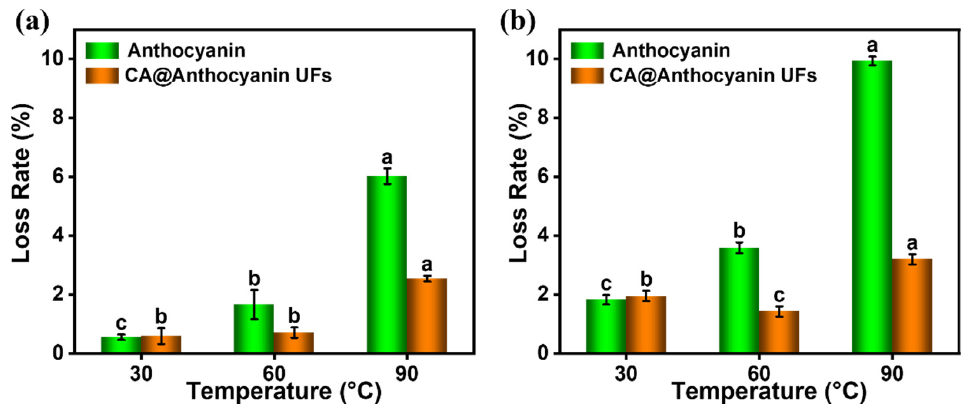
Figure 5. Loss rate of the anthocyanin and CA@Anthocyanin UFs under various water bath temperatures: ( a ) water bath time—2 h; ( b ) water bath time—6 h. Note: Different letters (a, b, c) represent significant differences ( p < 0.05) between